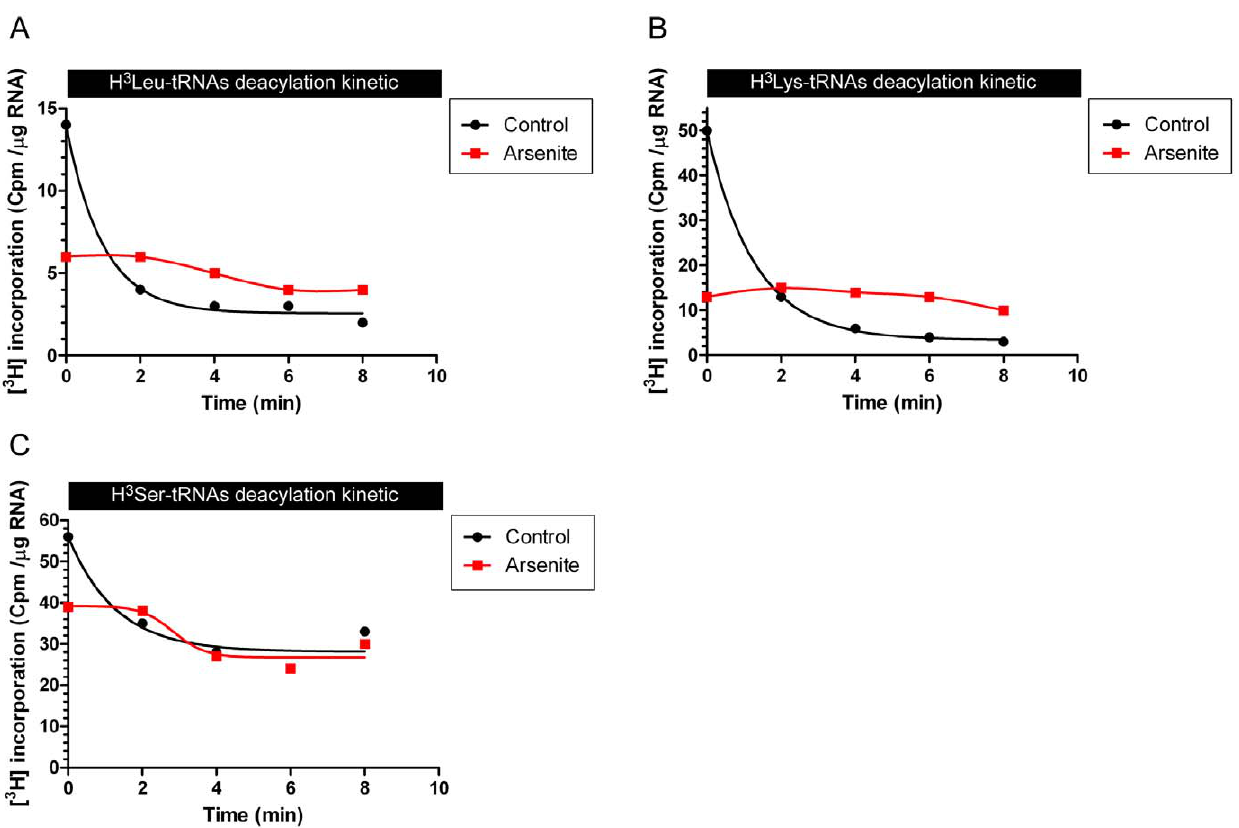
Figure 3. Leu-tRNA, Lys-tRNA and Ser-tRNA deacylation is coupled to translation. A. Kinetic of [ 3 H]-Leu deacylation on tRNAs extracted from HeLa cells treated or not with sodium arsenite. B. Same as ‘‘A’’ with [ 3 H]-Lys deacylation. C. Same as ‘‘A’’ with [ 3 H]-Ser deacylation.